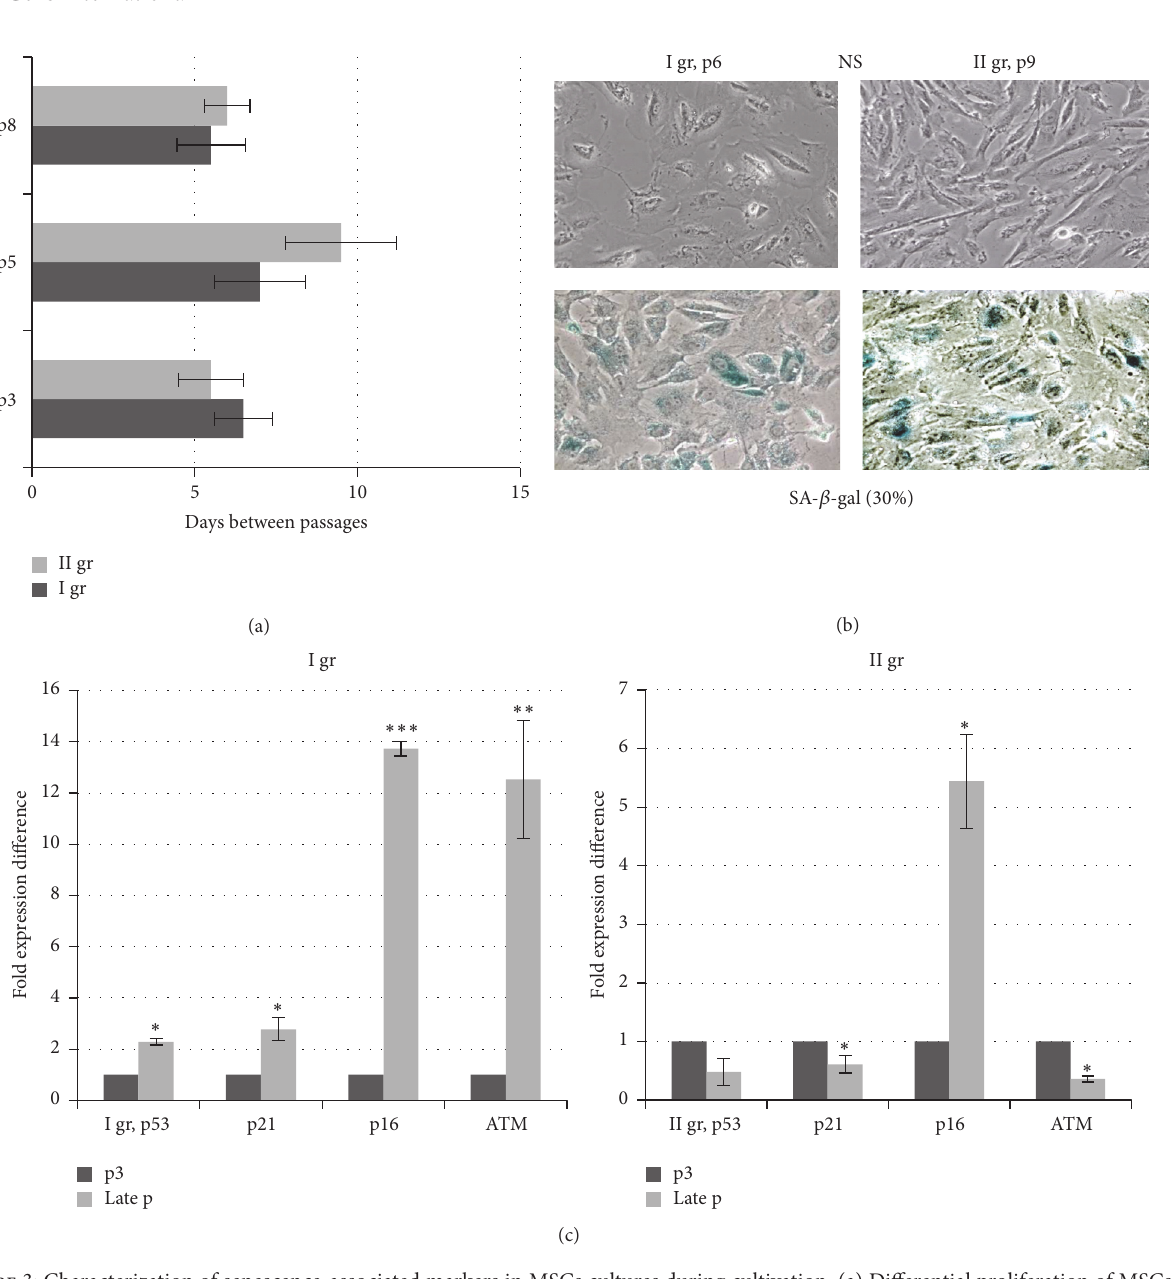
Figure 3: Characterization of senescence-associated markers in MSCs cultures during cultivation. (a) Differential proliferation of MSCs in two groups of cell cultures (I and II) during cultivation to passages 3, 5, and 8 ( 𝑛 = 3 , for each group). (b) Nonstained (NS) and SA- 𝛽 -gal positive cells at passages 6 and 9 in two groups of MSCs cultures. (c) Differential mRNA expression of senescence-associated markers in MSCs cultures (I gr and II gr) at passage 3 and the late passage was determined by RT-qPCR. Normalization to GAPDH and fold expression difference compared with passage 3 calculated using a comparative threshold cycle delta-delta Ct method. The data is presented as the mean ± SD ( 𝑛 = 3 , from each group). ∗ 𝑃 ≤ 0.05 , ∗∗ 𝑃 ≤ 0.01 , and ∗∗∗ 𝑃 ≤ 0.001 were considered as significant